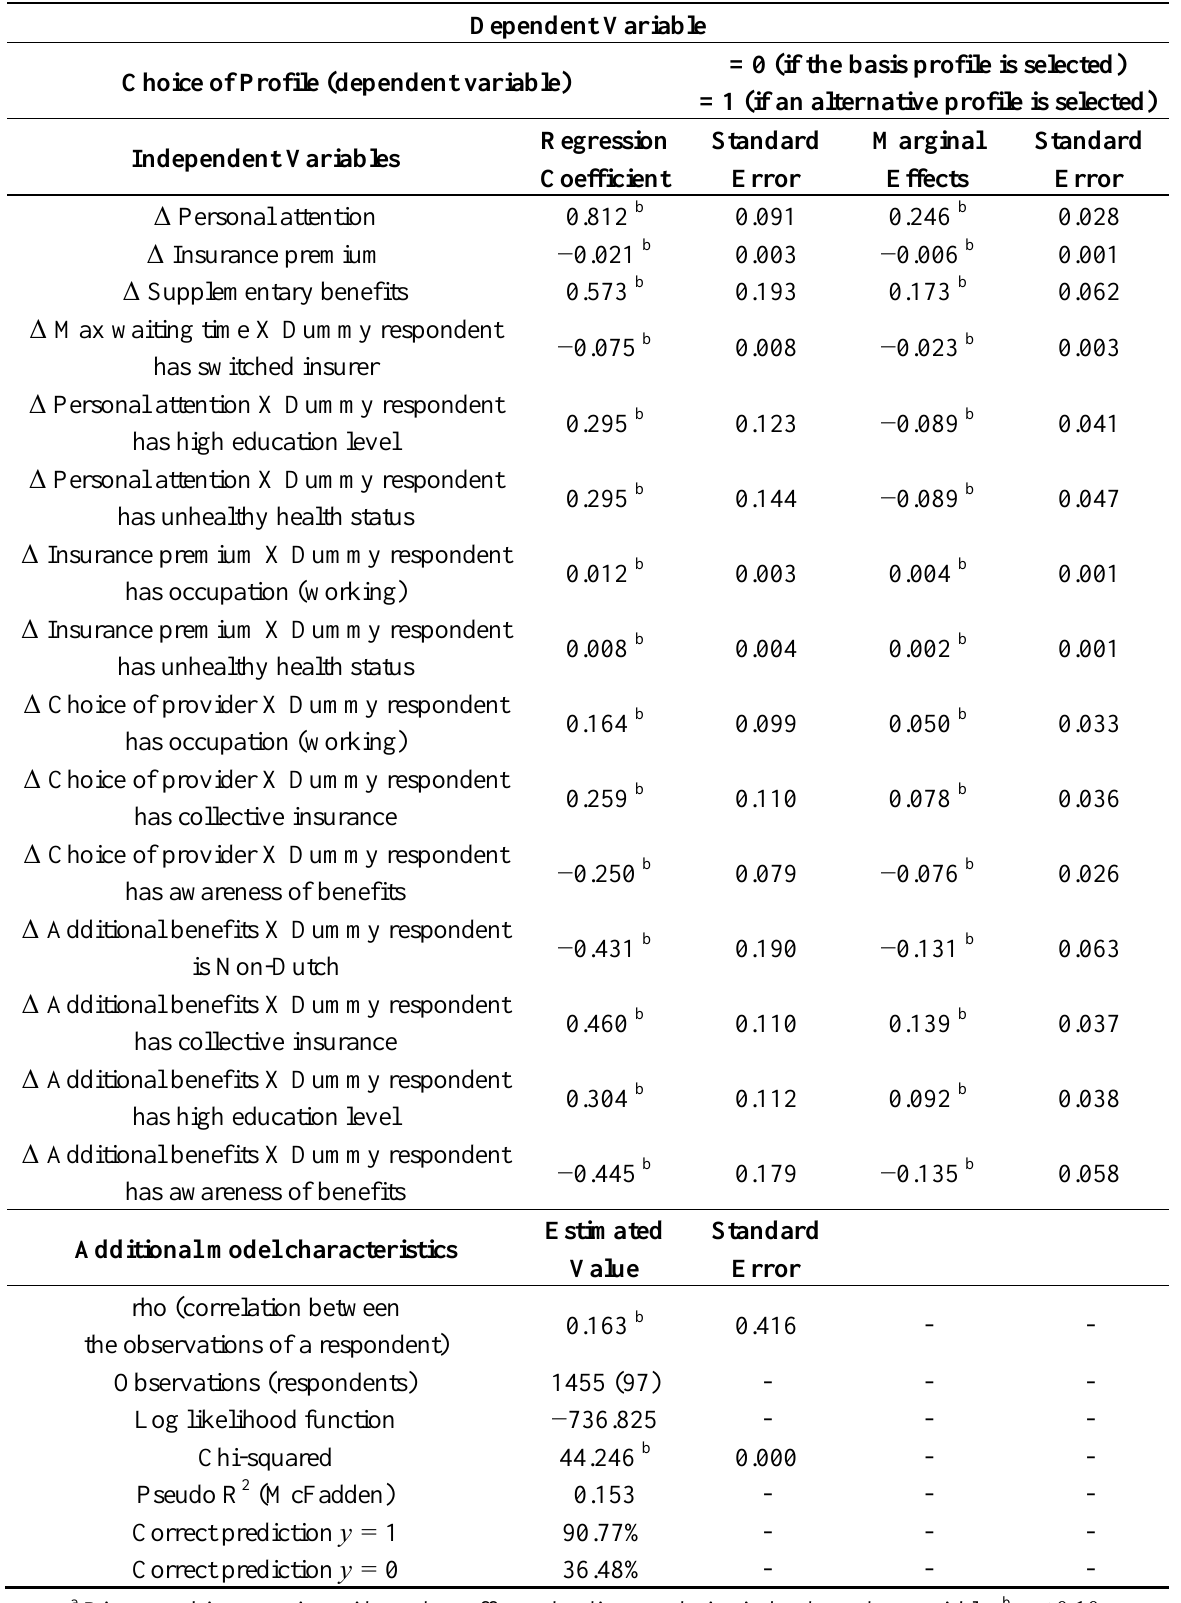
Table 8. Results of the discrete-choice experiment, reduced model a (Δ =